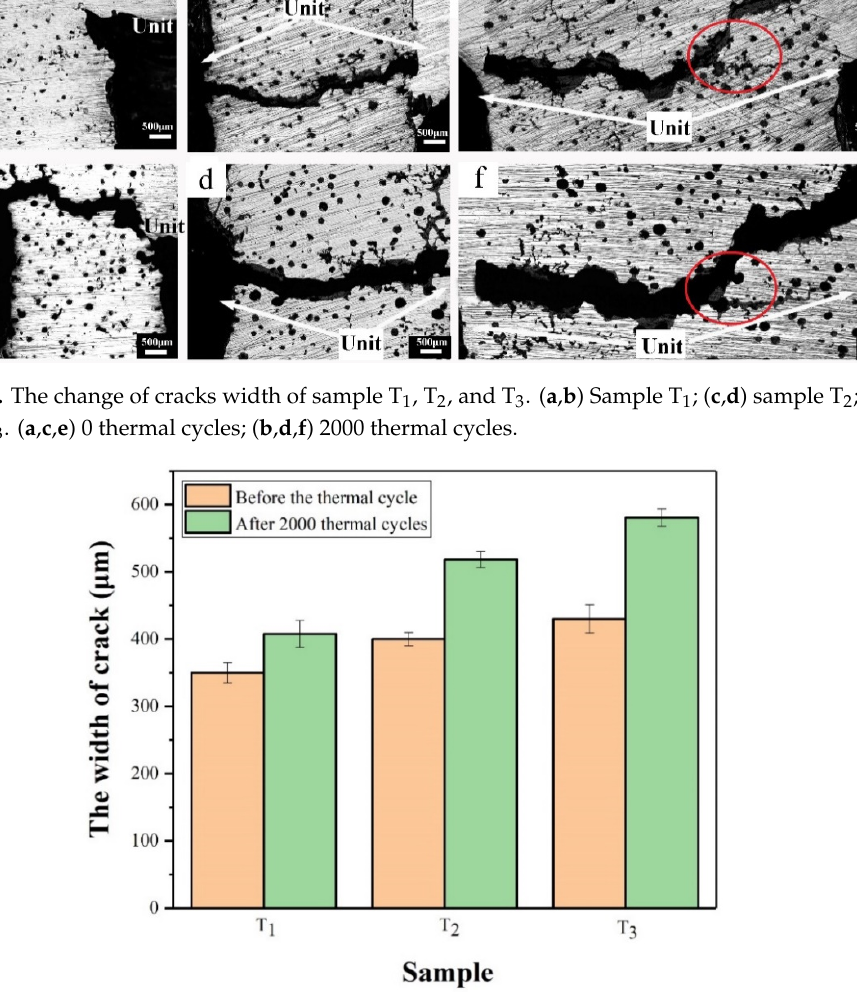
Figure 16. The crack width of sample T 1 , T 2 , and T 3 under different thermal cycles.